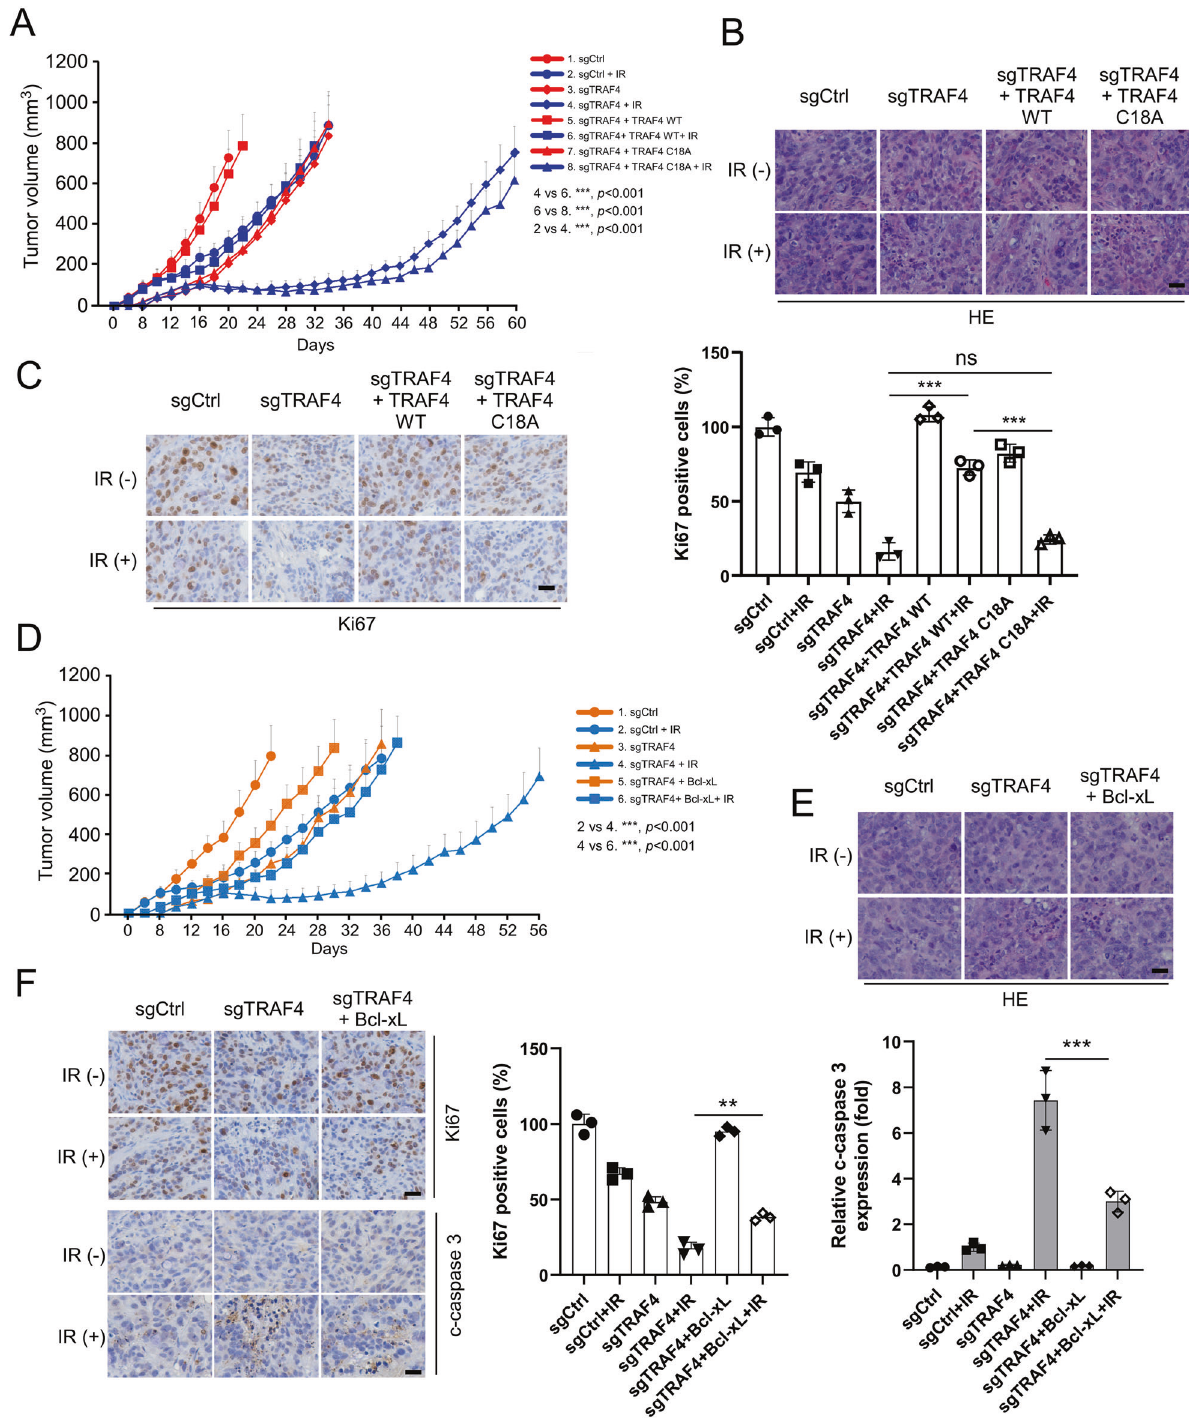
Fig. 6 TRAF4 knockout combined with irradiation inhibits tumor growth in vivo. A - C . TRAF4 reintroduction into TRAF4-null HT29 cells rescues tumorigenesis under IR treatment (2 Gy/twice per week). TRAF4 WT or TRAF4 C18A mutant was reintroduced into TRAF4 null-HT29 cells and subjected to in vivo tumorigenesis. ( n = 5 mice per group). Tumor growth curves ( A ) were recorded, tumor tissues were subjected to H&E ( B ) and IHC staining ( C ). For C, left, representative image; right, quali fi cation. Scale bar, 25 μ m. *** p < 0.001. D – F . Introduction of Bcl-xL into TRAF4-null HT29 cells rescues tumorigenesis under IR treatment (2 Gy/twice per week). Bcl-xL was introduced into TRAF4 knockout-HT29 cells and subjected to in vivo tumorigenesis. ( n = 5 mice per group). Tumor growth curves ( D ) were recorded, tumor tissues were subjected to H&E ( E ) and IHC staining ( F ). For F , left, representative image; middle and right, quali fi cation for Ki67 (middle) and cleaved-caspase 3 (right). Scale bar, 25 μ m.*** p < 0.001. ** p < 0.01. TNF receptor-associated factor 4, IR ionizing radiation, H&E hematoxylin and eosin, IHC